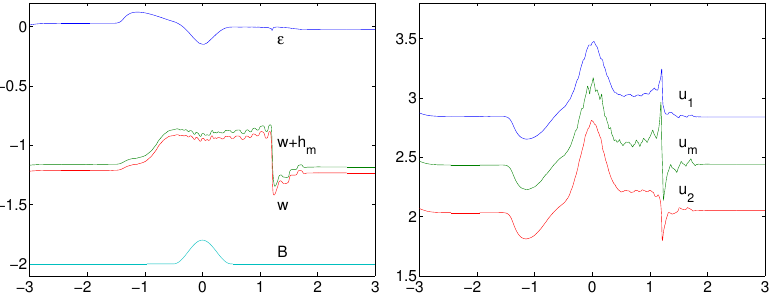
Figure 9. Example 2: Solution of the three-layer system with (cid:98) h m = 0 . 05.